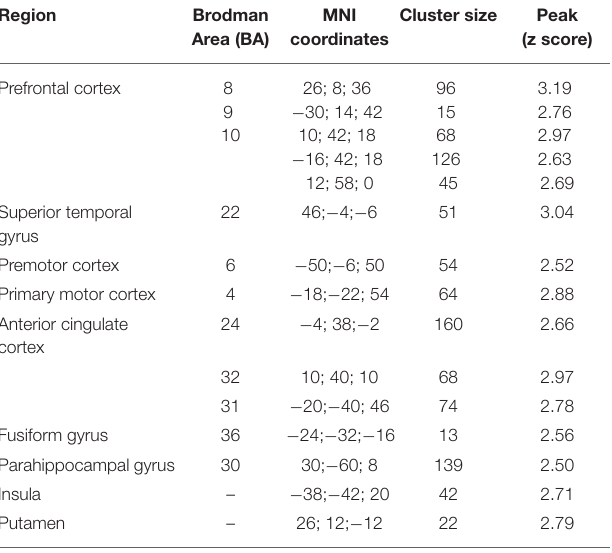
TABLE 3.1 | Main foci of activation for first person sentences in INS condition contrasted against RW. Region